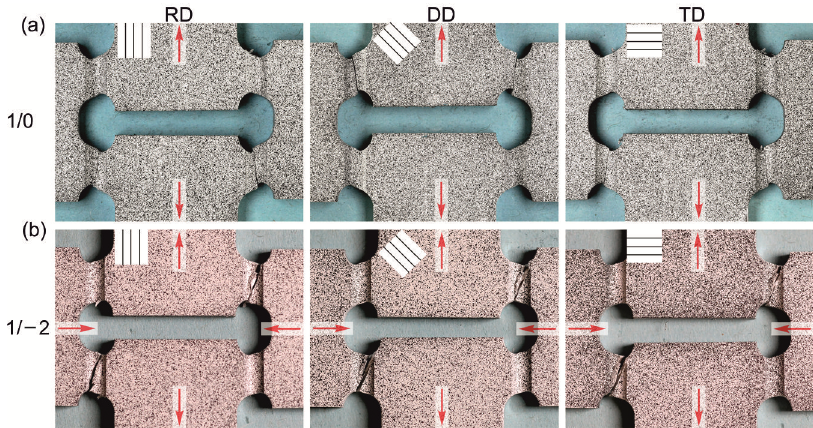
Figure 7. Fractured specimens: ( a ) load case 1/0 and ( b ) load case 1 /–2.